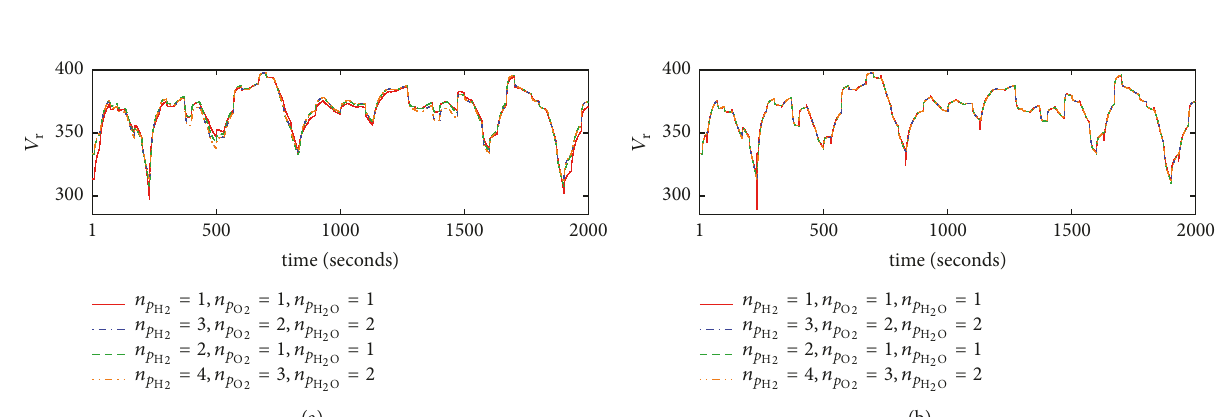
= 4 , 𝑛 = 3 , and 𝑛 = 2 ) models determined 𝑝 O 2 𝑝 H 2 O H 2